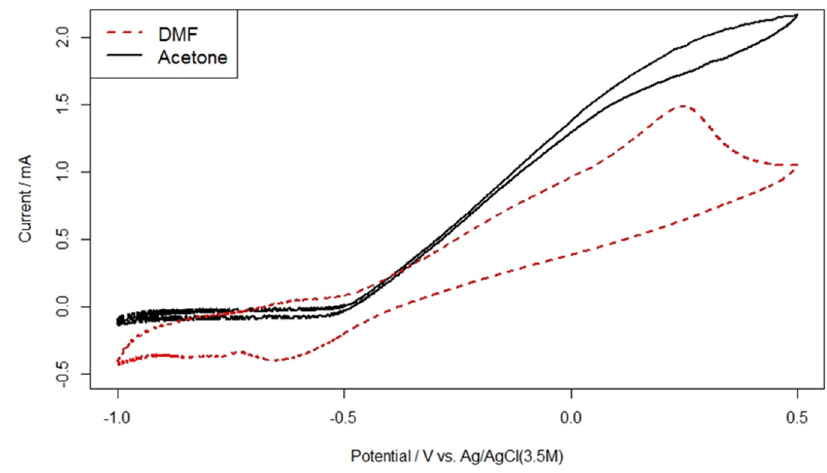
Figure 5. Cyclic voltammograms recorded under turnover conditions (scan rate of 0.1 mV · s − 1 ). The control electrode produced a negligible current and is not presented here.